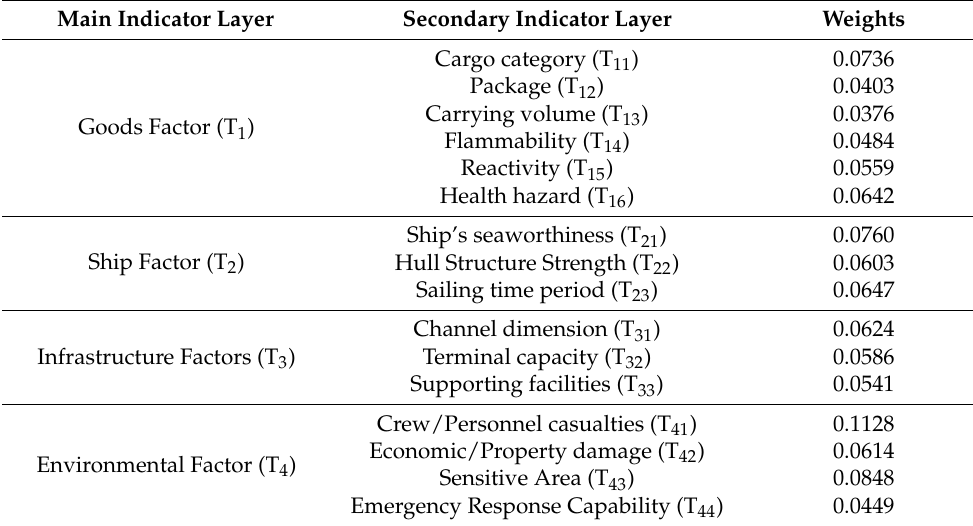
Figure 5. Thoughts on determining the transportability assessment index. Table 1. Evaluation system and weight distribution of transportability level